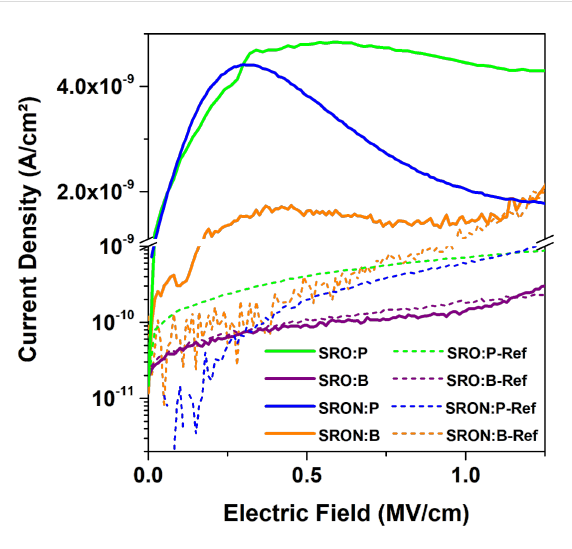
Figure 6: J – E data of injection-blocking MOS-capacitors with P- or B-incorporating Si NCs in SRO and SRON and their directly corre- sponding references (SRO:P with 0.59 atom %, SRON:P with 0.48 atom %, SRO:B with 1.32 atom %, SRON:B with 0.14 atom